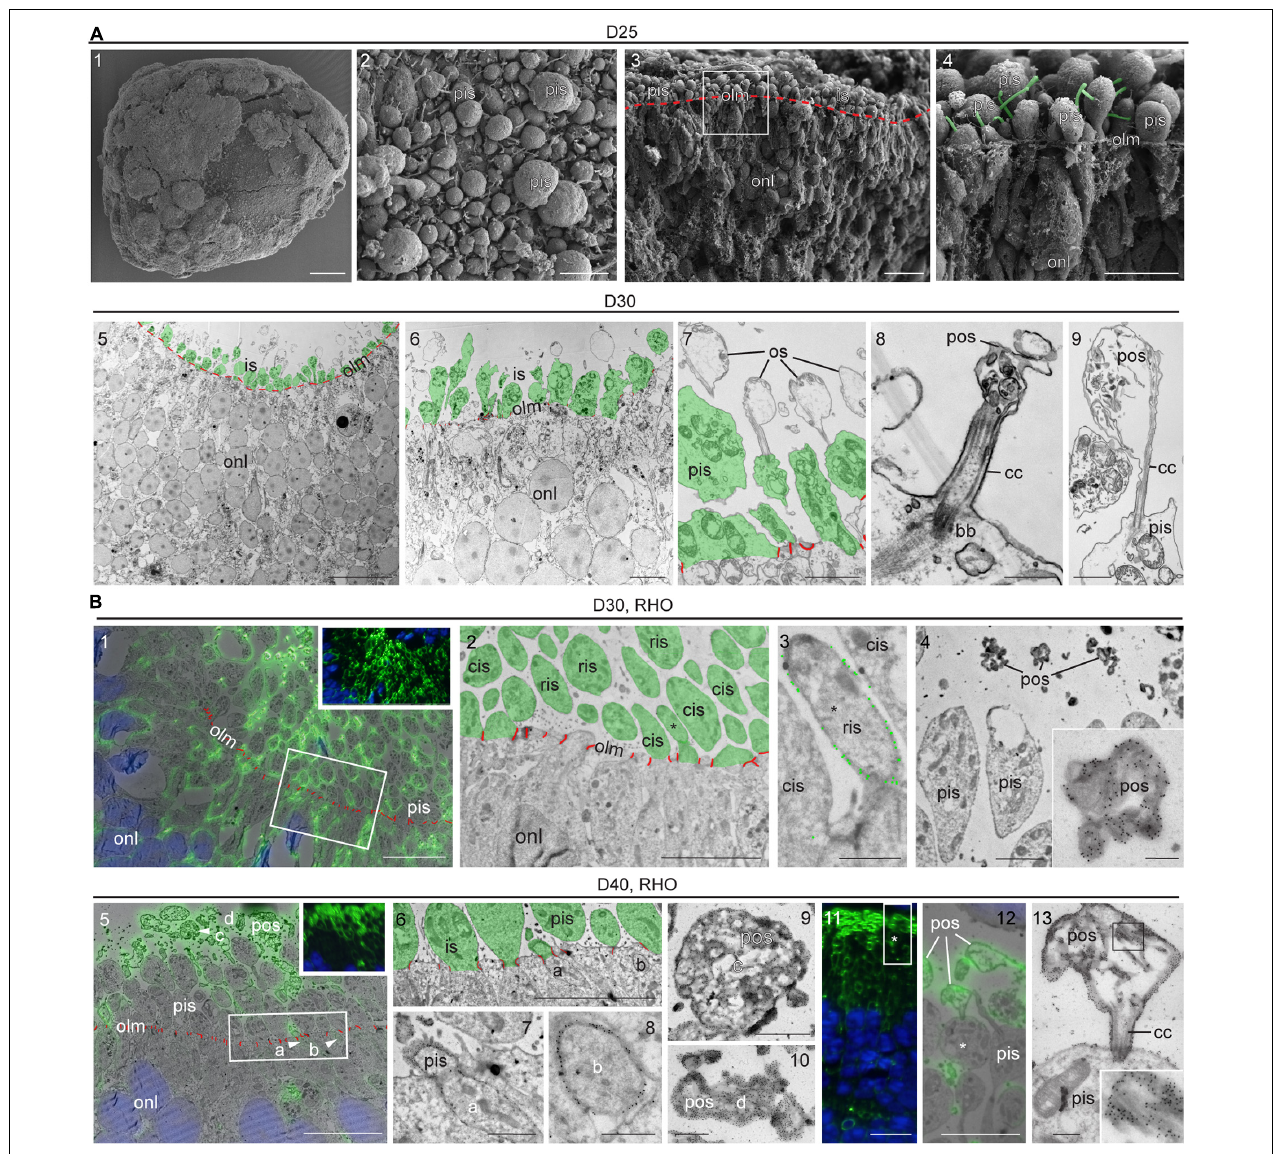
FIGURE 4 | Ultrastructure of photoreceptor maturation and outer segments formation. (A1–4) Scanning electron microscopy (SEM) of D25 MROs. (A1) overview of whole organoid, (A2) surface of organoid with photoreceptor inner segments. (A3,4) SEM of retinal organoid after dissection, the sample fractured preferentially between cell borders (cross-section). (A3) Overview, the outer limiting membrane (i.e., apical surfaces of MRO cells) is indicated by the red dashed line. (A4) The region indicated by the square in (A3) . Cilia emerging from the inner segments are pseudo-colored in green. (A5–9) Transmission electron microscopy (TEM) of